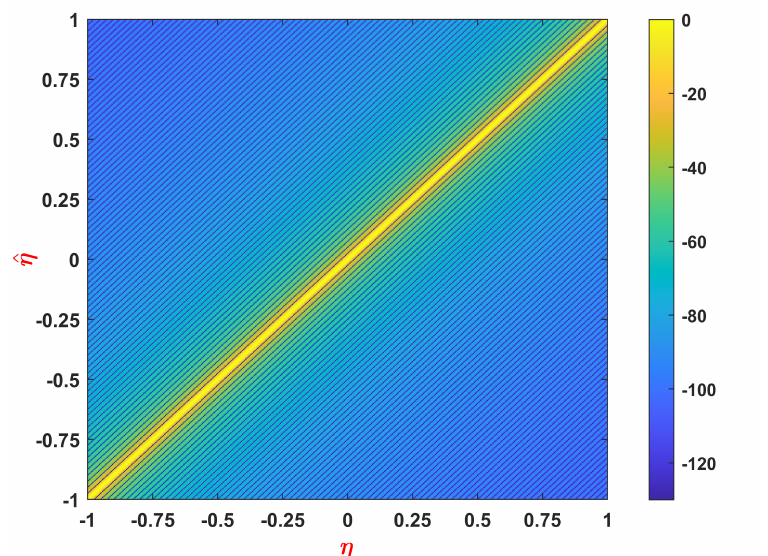
Figure 3. Approximated kernel of A 1 A † z o = 5 λ , X 1 = 5 a